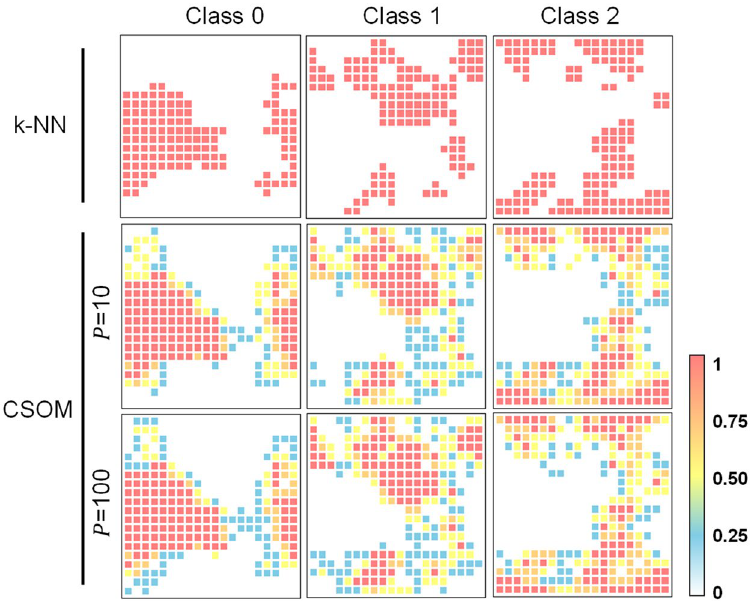
Figure 3. Differences in class probabilities when mapping wines data set in a 20 × 20 SOM using k-NN and CSOM algorithms. Higher P value refer to areas with higher class